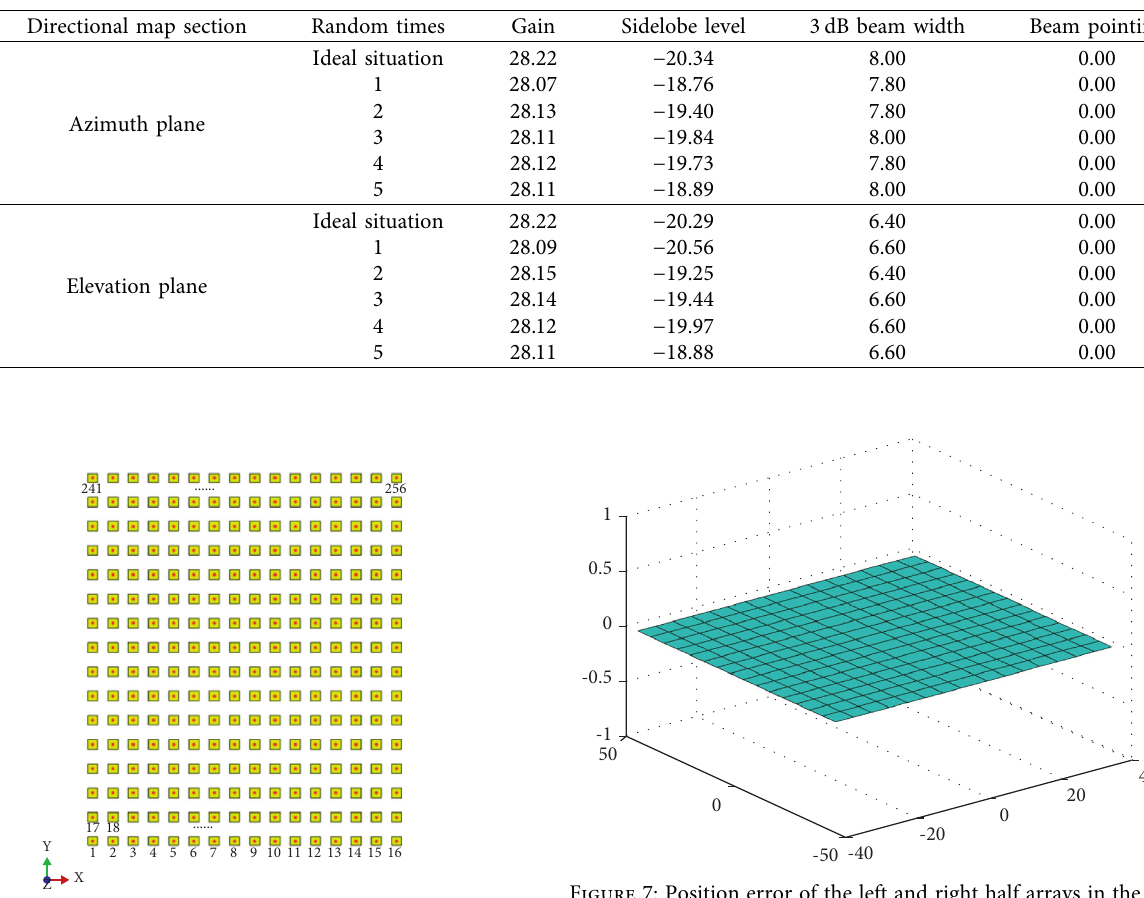
Figure 5: Simulation results of antenna pattern with five random amplitude and phase errors. (a) Azimuth plane. (b) Elevation plane. Table 2: Five-order random amplitude and phase error antenna technical index statistics.